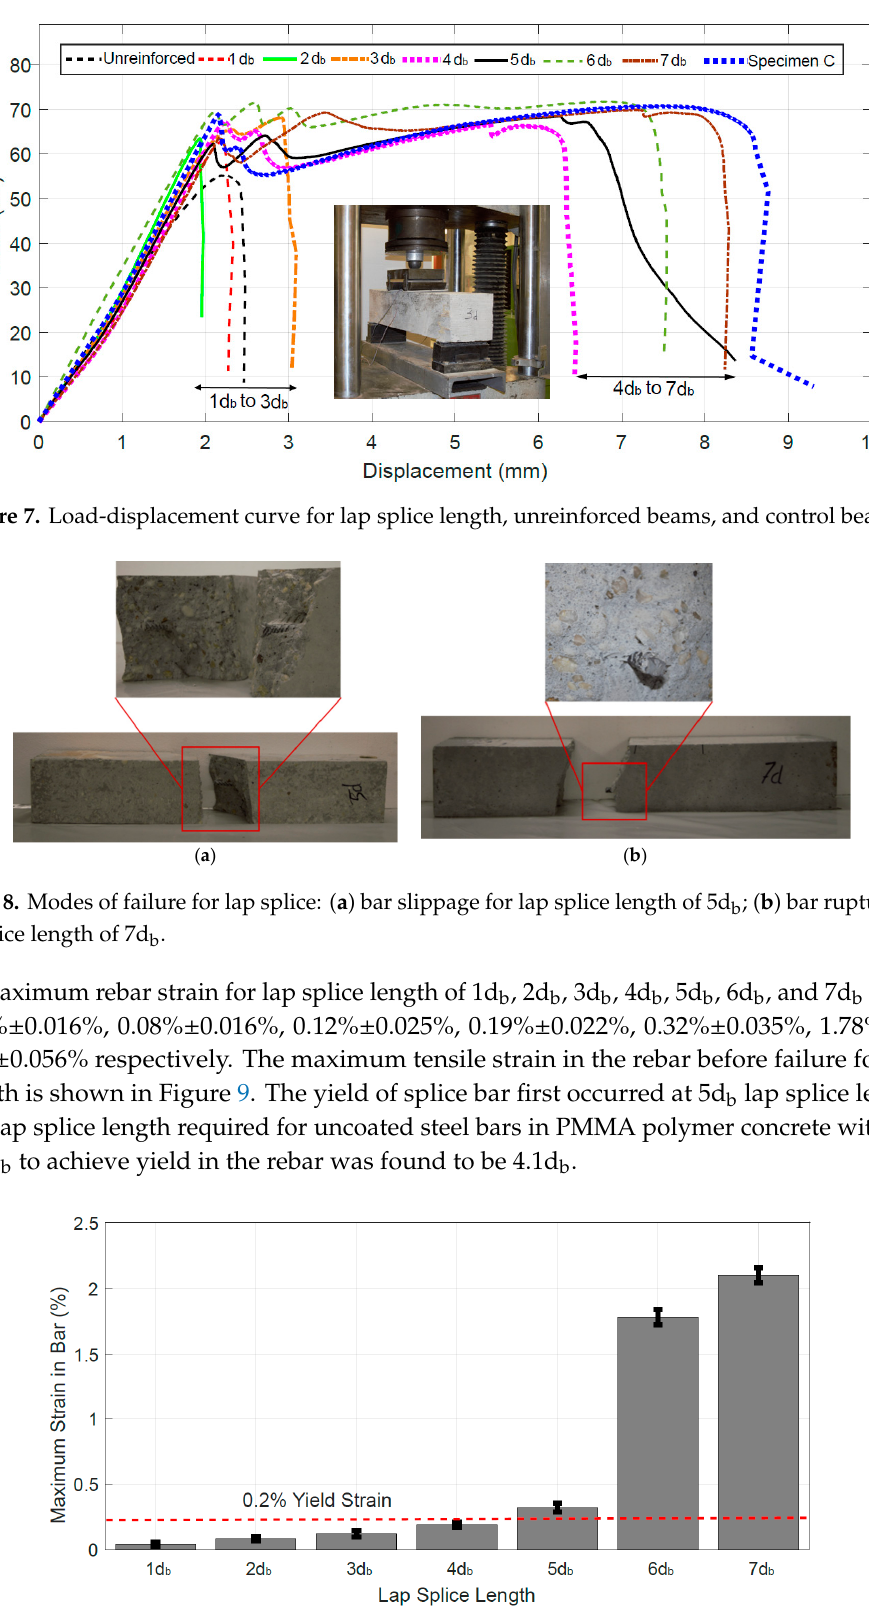
Figure 9. The maximum tensile strain in the rebar before failure for each lap splice length (red line represents the yield strain of the steel rebar “0.20%”).